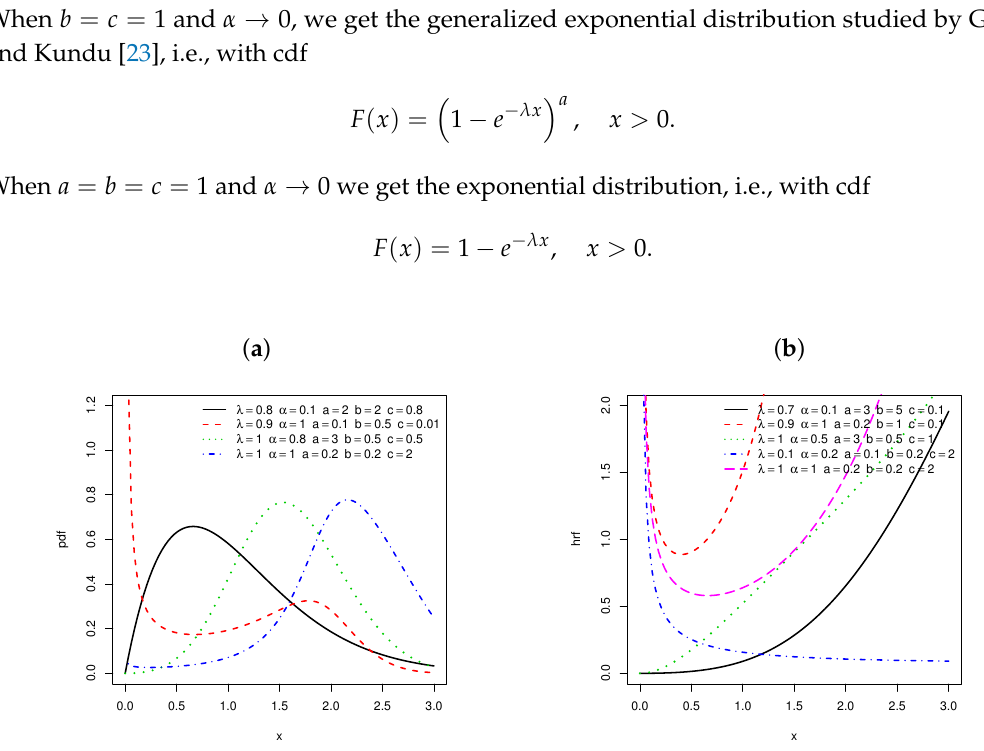
Figure 1. Some plots of the pdf f ( x ) ( a ); and some plots for the hrf h ( x ) ( b